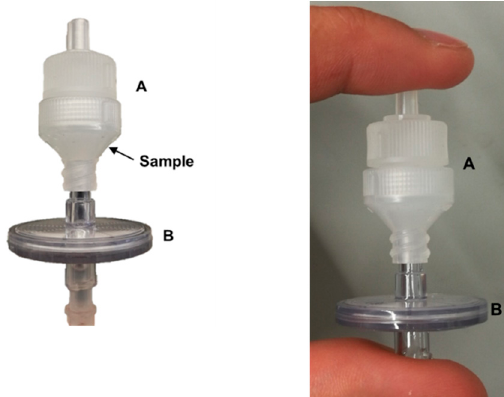
Figure 1. Extraction chamber (EC), composed by a polypropylene disk holder ( A ) with 25 mm of internal diameter containing a Fluoropore™ membrane filter (polytetrafluoroethylene), with a 1.0 µm pore, and by a Millex ® syringe filter (polyvinyl chloride housing and polyvinylidene fluoride membrane), with a 5.0 µm pore ( B ). Dry dog food sample is placed inside the EC, as indicated by the arrow, through the wide opening of the disk holder (Supplementary Information, Figure S1).